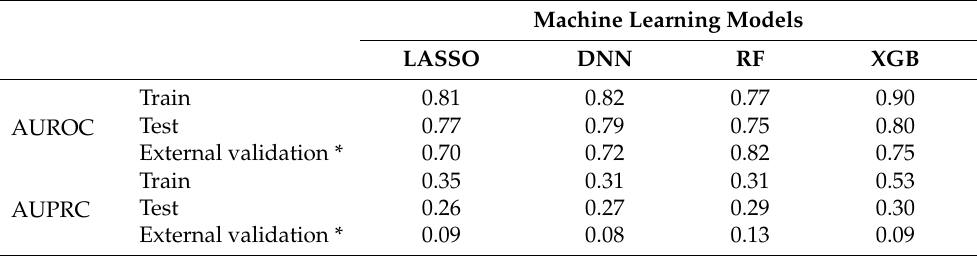
Table 4. Performance metrics between developed models developed with only postoperative blood test